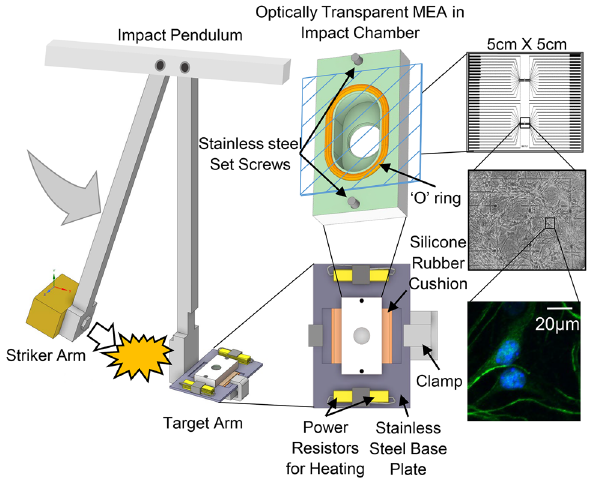
Figure 1. “TBI-on-a-chip” Injury model. Acceleration injury is generated by the impact pendulum (left): the striker arm swings down from a preselected height, making contact with the target arm and stainless steel baseplate/chamber assembly (enlarged). This assembly is airtight and functions as a sort of “miniature- incubator,” capable of protecting the network adhered to MEA while maintaining 5 mL of culture media at physiological pH, osmolarity, and temperature, for the duration of the impact application. The base plate includes 2 pairs of 4 Ω resistors for heat generation, and a silicone rubber cushion for the MEA. Two stainless steel set screws connect the chamber block to the base plate. Inverting the chamber reveals a silicone “O” ring, which connects to the topside of the optically transparent MEA (represented with cross hatching, and enlarged on right). The microscope window (70 µm cover glass) provides morphological access to networks. A typical MEA conductor pattern (two groups of 32 transparent indium tin oxide cruciform electrodes, spin coated with methyl-trimethoxysilane resin, laser deinsulated and electrolytically gold plated) is shown, with and without cells (right). An enlarged fluorescent image illustrates the type of resolution available with this